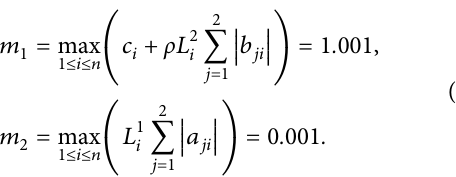
� 0 . 5 of differential